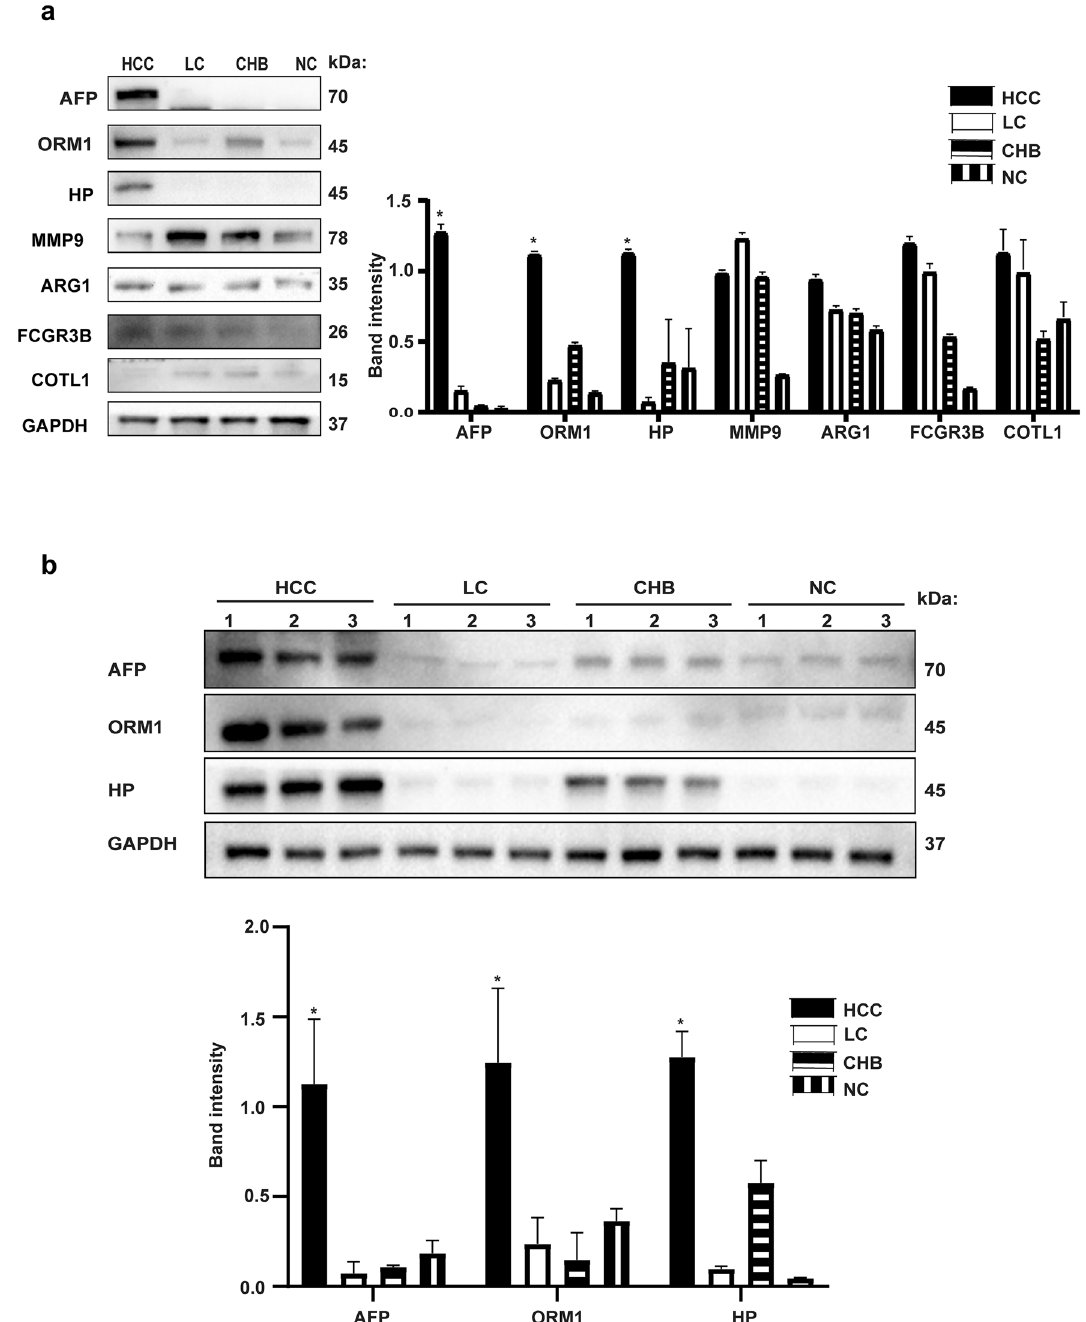
Figure 1. Western blot verification. ( a ) Representative images of Western blot for AFP, HP, ORM1, ARG1, COTL1, FCG3B and MMP9 in HCC, LC, CHB and NC mixed saliva; Analysis of band densities by Image J. ( b ) Representative images of Western blot for AFP, HP, and ORM1 in 3 subjects’ saliva from HCC, 3 subjects’ saliva from LC, 3 subjects’ saliva from CHB and 3 subjects’ saliva from NC; Analysis of band densities by Image J. The samples derive from the same experiment and blots were processed in parallel. Original blots are presented in Supplementary Figure. HCC hepatocellular carcinoma, LC liver cirrhosis, CHB chronic viral hepatitis B, NC normal control, AFP α-fetoprotein, HP Haptoglobin, ORM1 Orosomucoid1, ARG1 Arginase-1, COTL1 Coactosin-like protein, FCGR3B Low affinity immunoglobulin gamma Fc region receptor III-B, MMP9 Matrix metalloproteinase-9. Data are shown as mean ± SD, * p < 0.05, versus liver cirrhosis, chronic viral hepatitis and normal